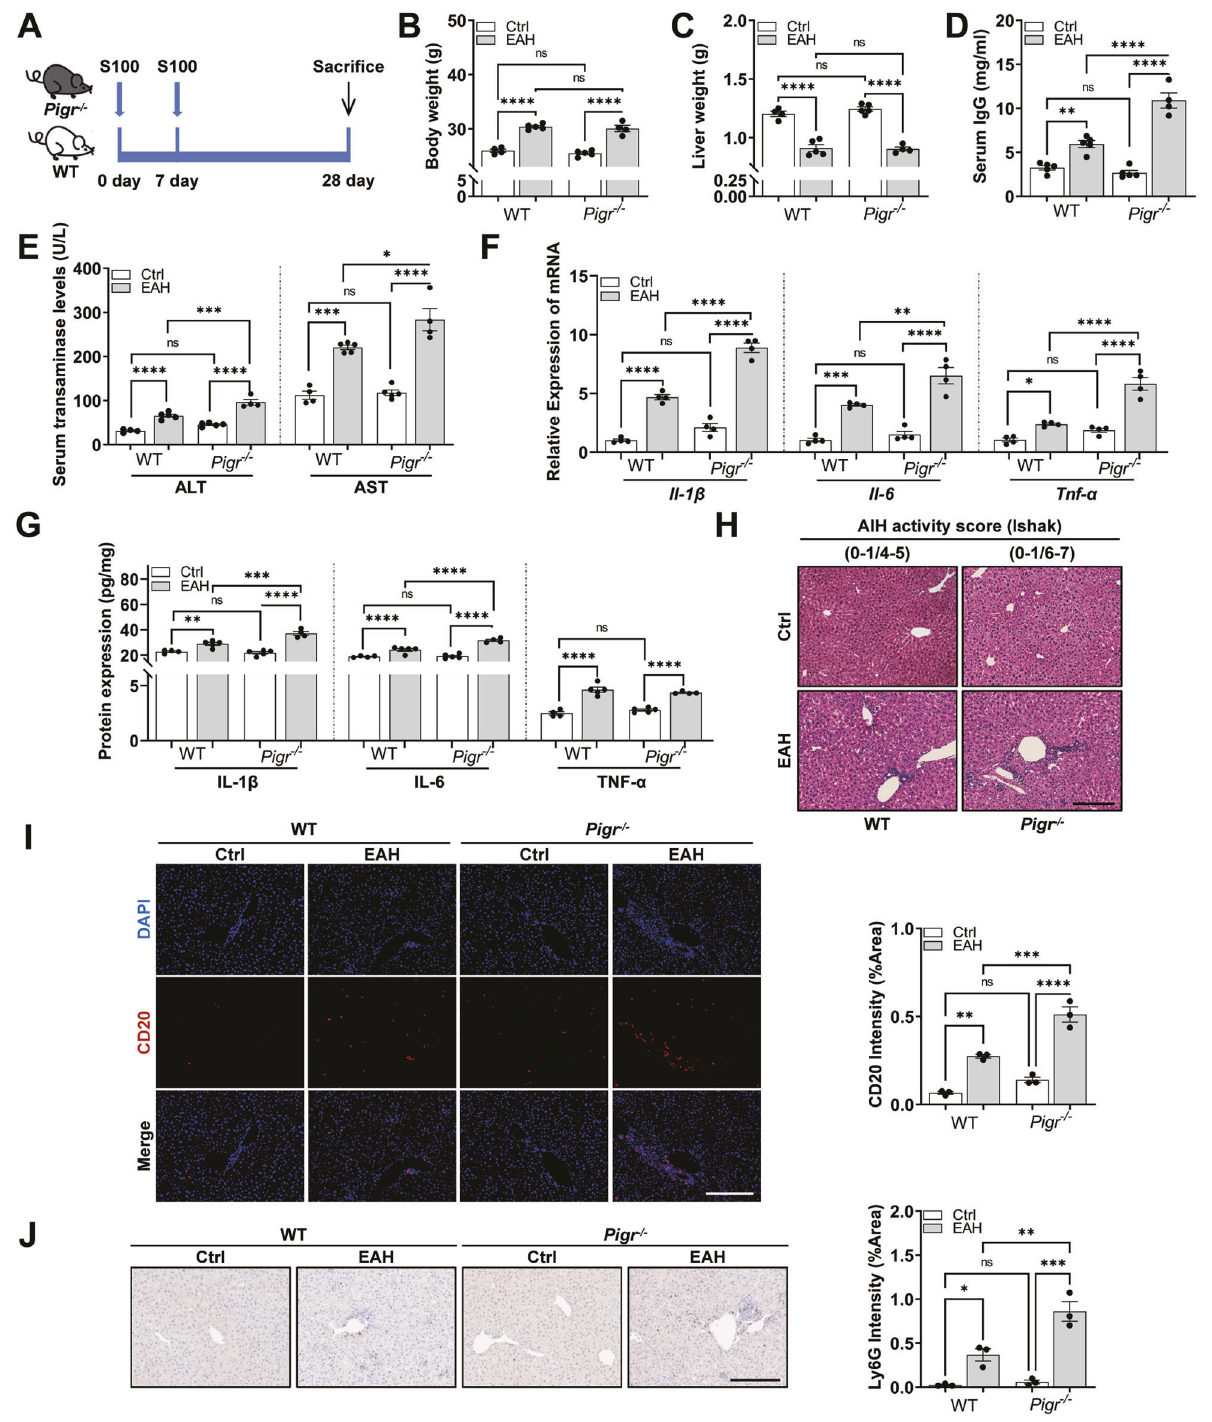
Fig. 2 Pigr − / − mice have exacerbated S100-induced liver injury. A The modeling process of EAH. B , C Body weight and liver weight. D Serum immunoglobulin G (IgG) level. E Serum ALT and AST levels. F , G Hepatic gene and protein expression of pro-in fl ammatory cytokines IL-1 β , TNF- α , and IL-6. H H&E staining of the liver. Scale bar = 200 μ m. I CD20 staining of the liver. Scale bar = 200 μ m. J Ly6G staining of the liver. Scale bar = 200 μ m. Data are presented as mean ± SEM. Statistical analysis was performed using one-way ANOVA with Tukey multiple